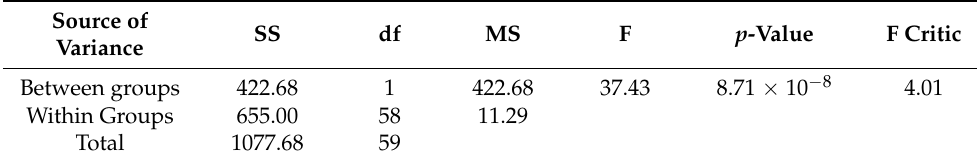
Table 21. ANOVA comparing results of trapezoidal